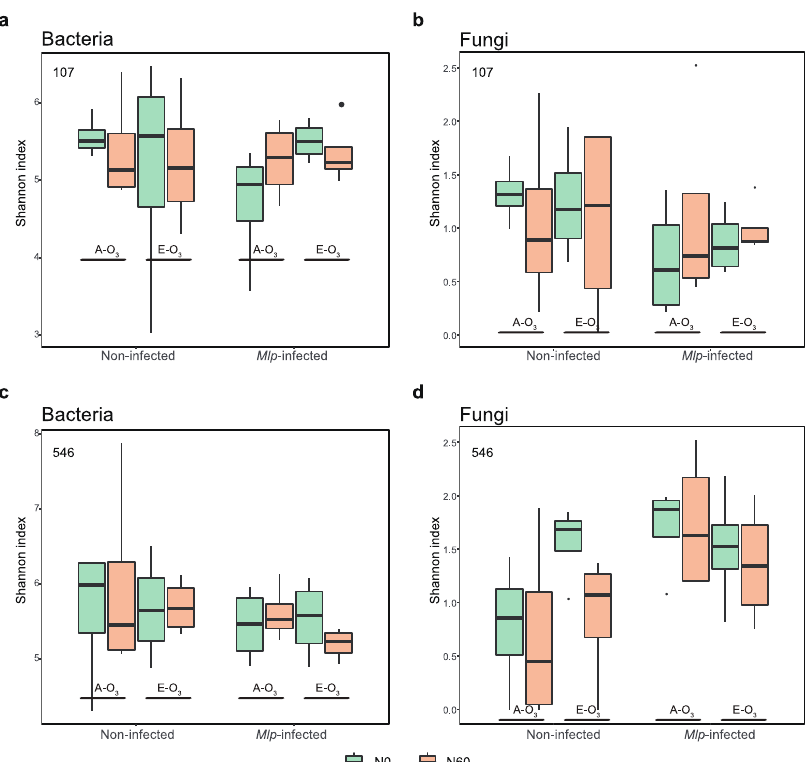
Figure 3. Shannon indices of phyllosphere communities of non ‐ infected leaves and Mlp ‐ infected leaves of the clone ‘107’ ( a , b ) and the clone ‘546’ clone ( c , d ) from ambient ozone concentration plots (A ‐ O 3 ) and elevated ozone concentration plots (E ‐ O 3 ) with nitrogen addition (N60) and without ni ‐ trogen addition (N0). Box plots showed the range of estimated values between 25% and 75%, the median, the minimum, and the maximum observed values within each dataset. median, the minimum, and the maximum observed values within each